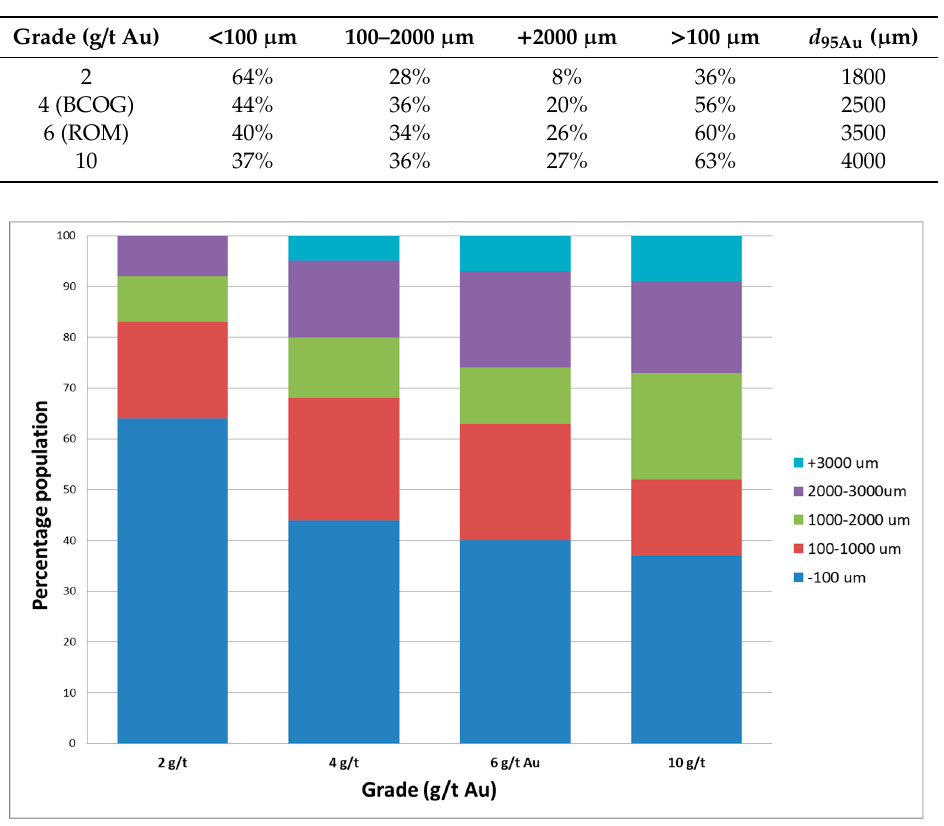
Figure 2. Gold particle size distribution by mass across different grades (after Table 4).